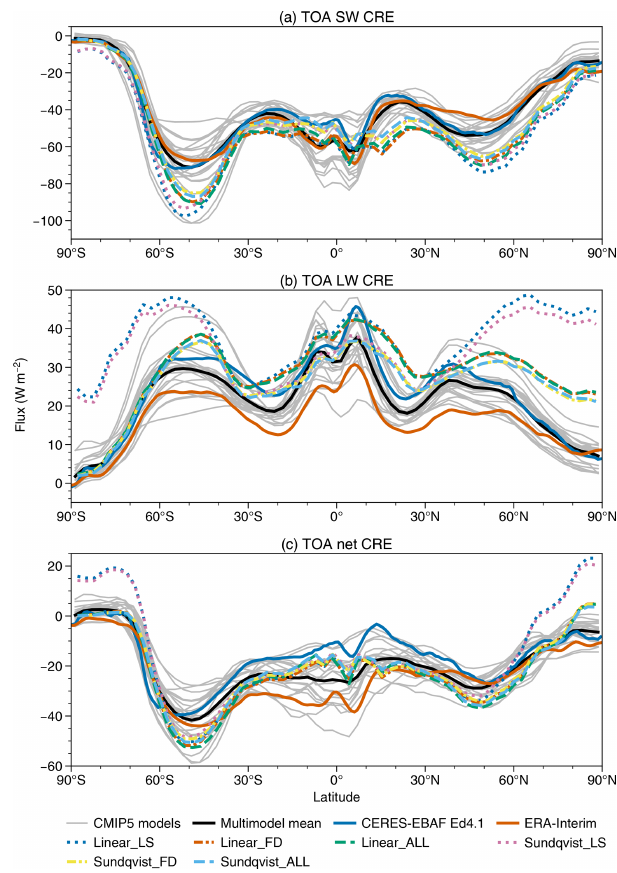
Figure 15. Zonally averaged distribution of the TOA (a) SW, (b) LW and (c) net CREs from CERES-EBAF Ed4.1 (solid blue line), ERA-Interim reanalysis (solid orange line), CMIP5 models (thin, solid gray lines for each model and solid black line for mul- timodel mean) and different Isca simulations (dashed or dotted col- ored lines, listed in